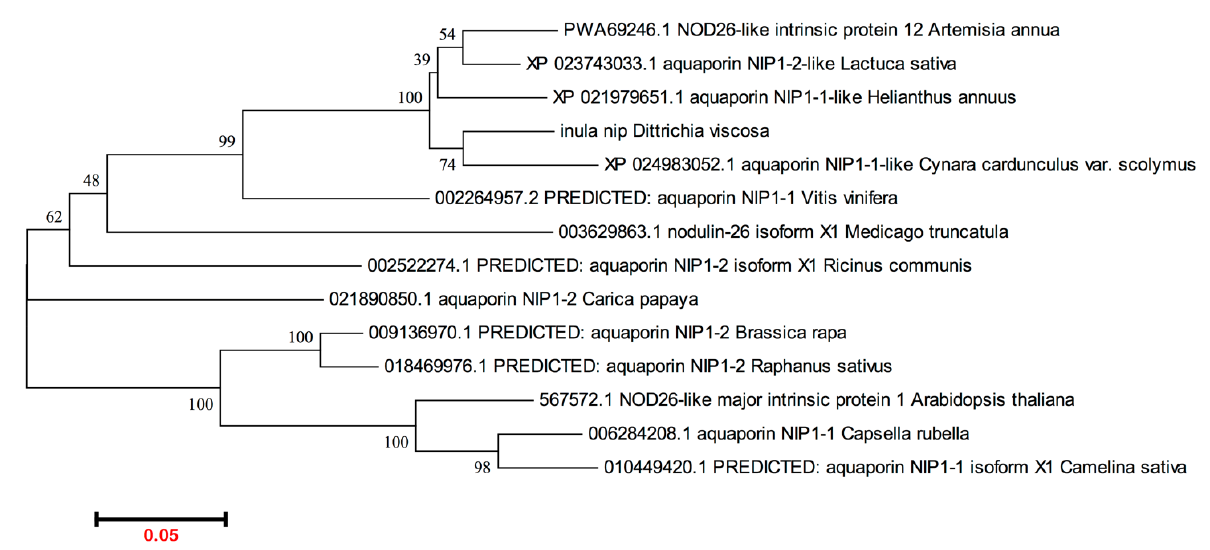
Figure 2. Phylogenetic analysis of plant NIPs1. The sequences were retrieved from NCBI genbank: >XP_023743033.1 aquaporin NIP1-2-like ( Lactuca sativa ); >XP_024983052.1 aquaporin NIP1-1-like